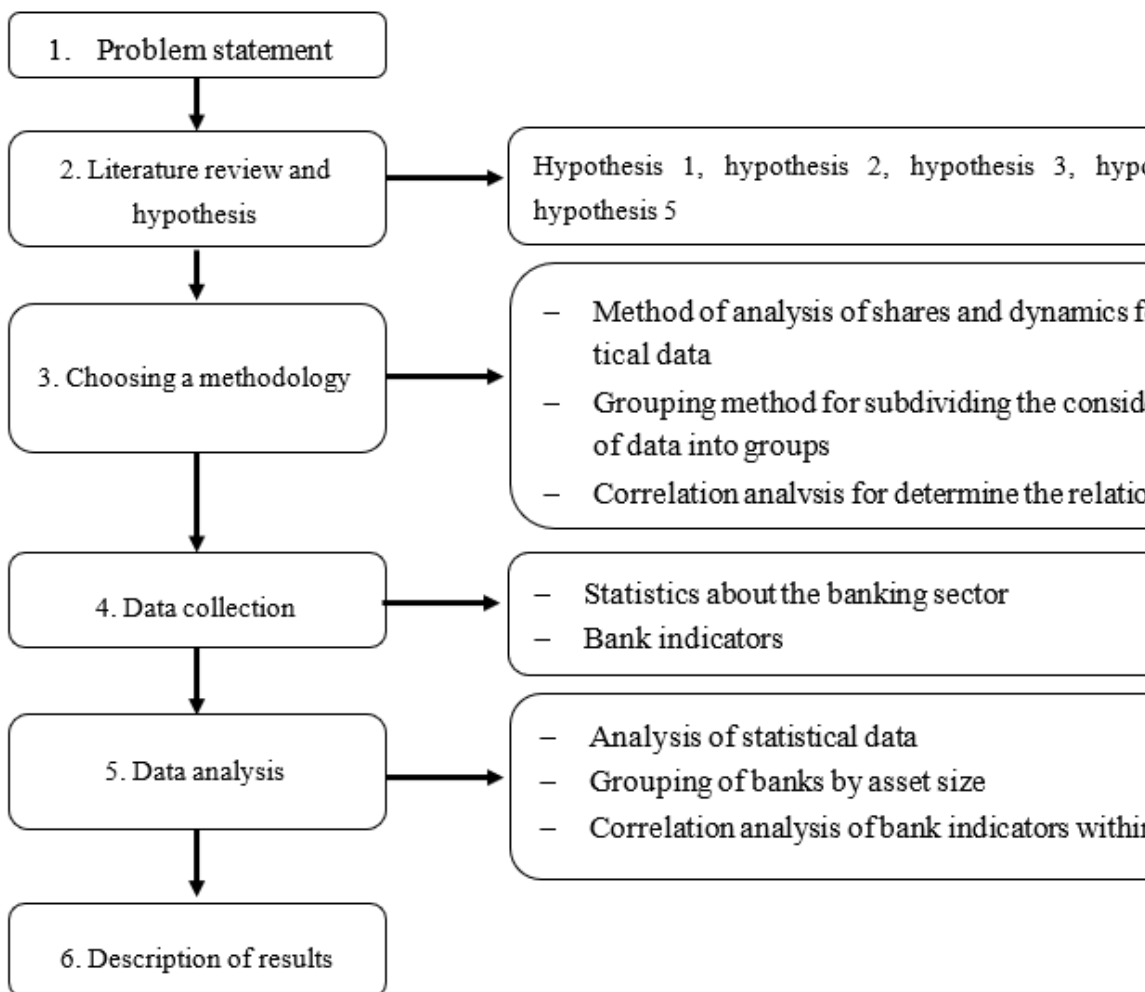
Figure 2. Research methodology